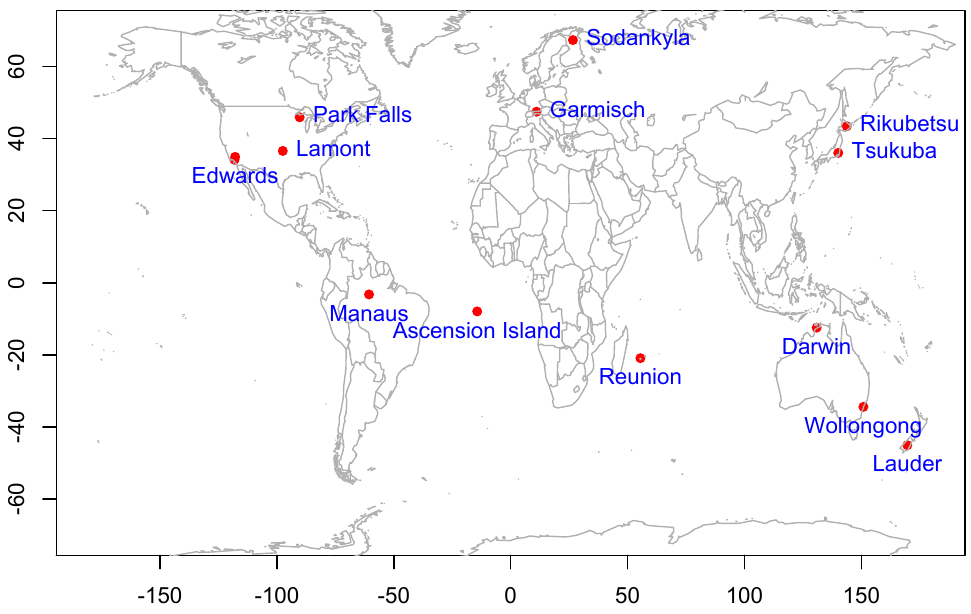
Figure 1. Locations of the 14 TCCON sites that were used to compare to column-averaged, data-fused CO 2